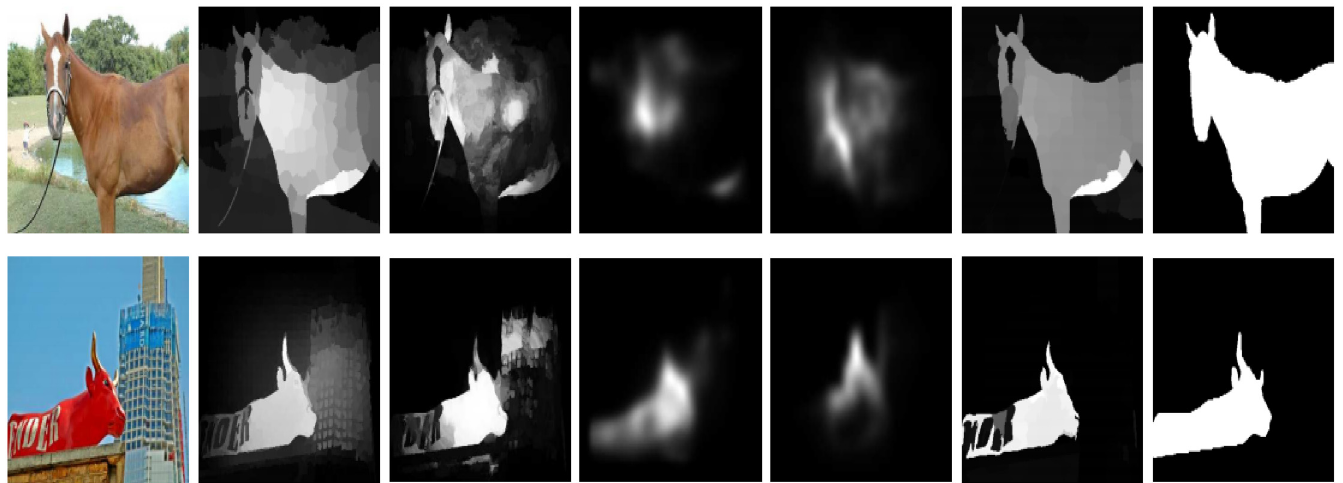
Fig 1. The reliability and accuracy of our designed method in the case, when the salient objects are touching marginally or completely to the image boundaries. The results are presented as: Input Image (II), MF [16], DS [6], DL [7], MT [8], the proposed model, and the Ground Truth (GT). The results are similar but not identical to the original images and is therefore for illustrative purposes